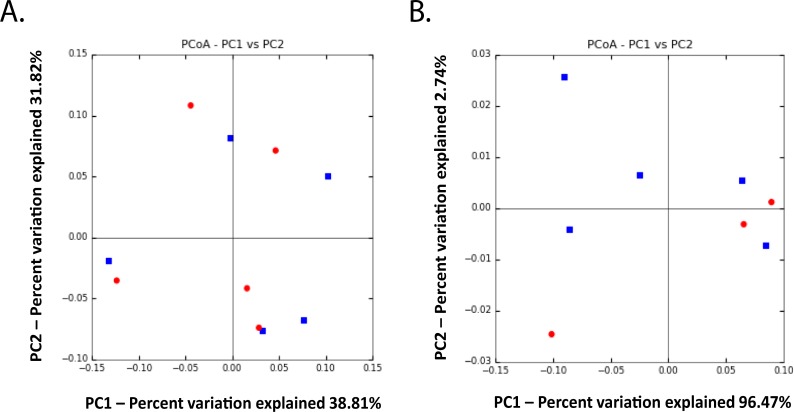
Principal coordinate analysis (PCoA) of microbial communities from the cecum of wild ptarmigans based on 16S rRNA amplicon sequencing data.Plots were generated based on weighted UniFrac distance matrices. A) PCoA plot of bacterial community structure; B) PCoA plot of archaeal community structure. Blue square: Svalbard ptarmigan. Red circle: rock ptarmigans northern Norway.